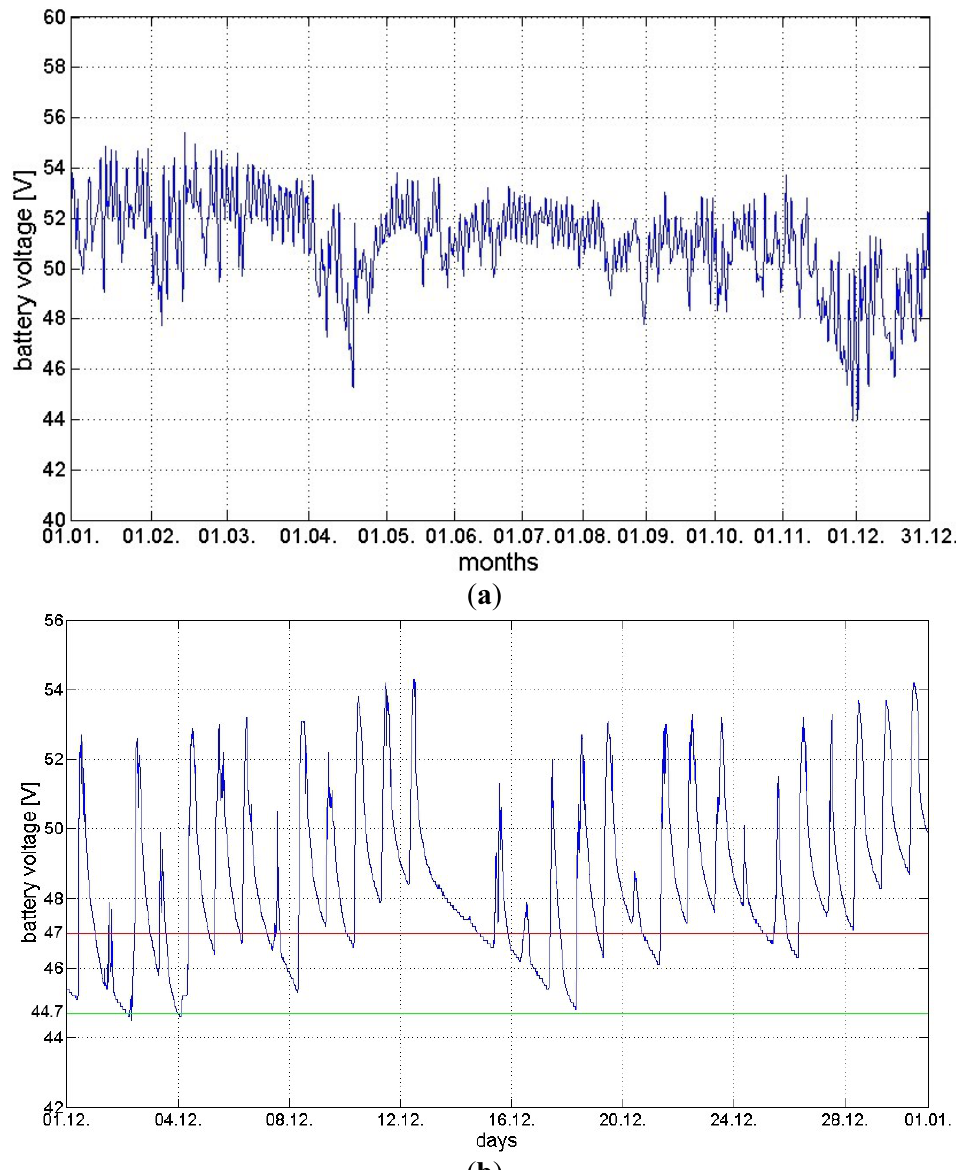
Figure 4. ( a ) Yearly variation of battery voltage for the BSS A; ( b ) the BSS A battery voltage variation during